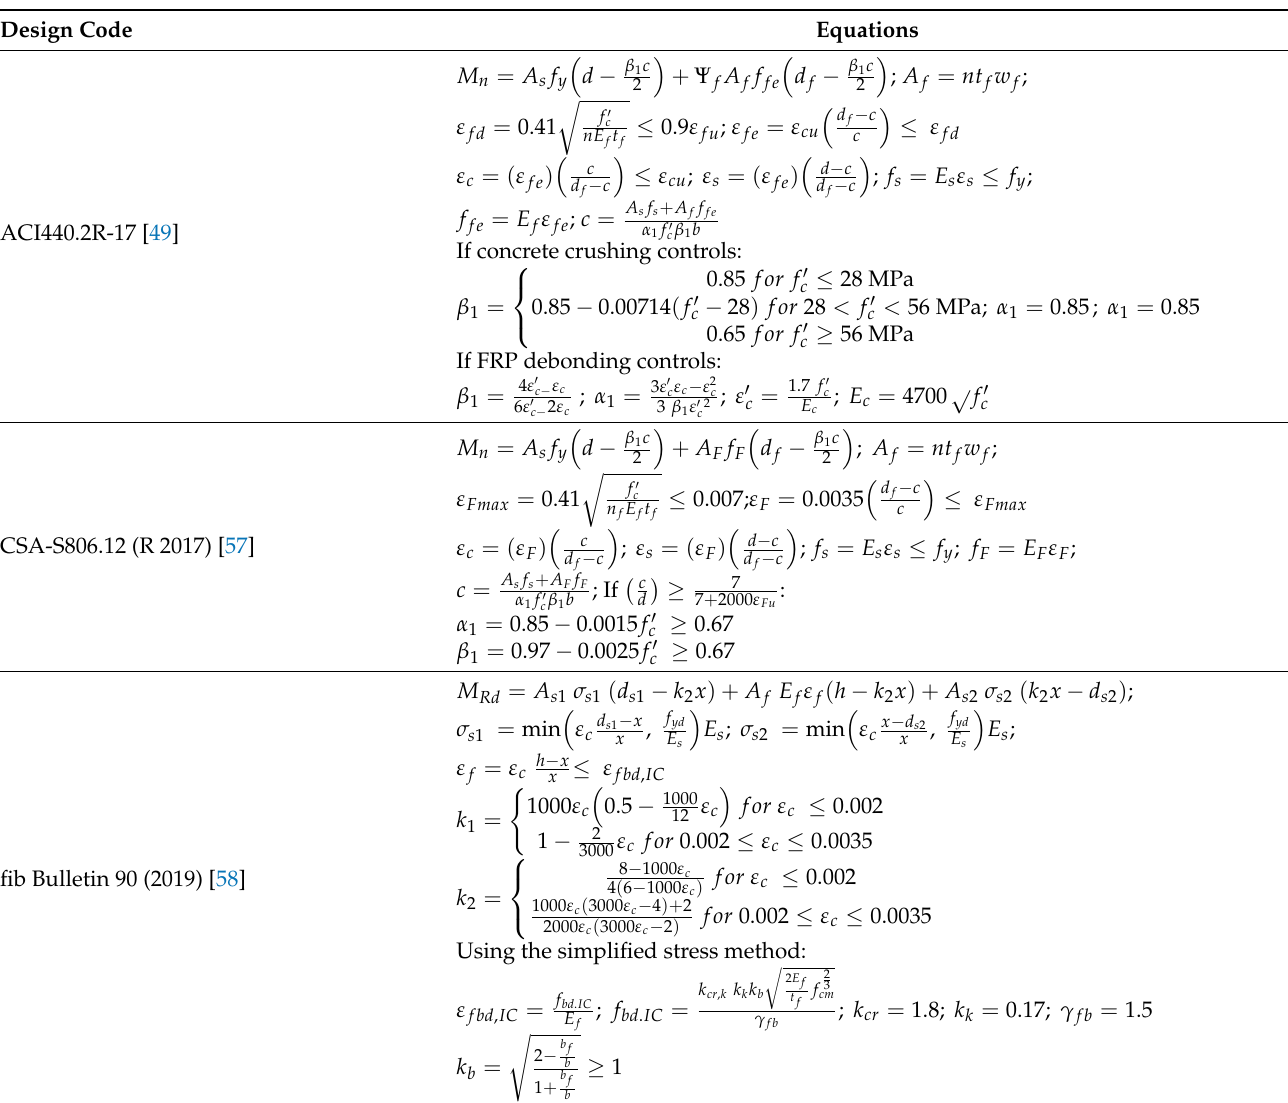
Table 5. Summary of equations for determining flexural capacity of FRP-strengthened